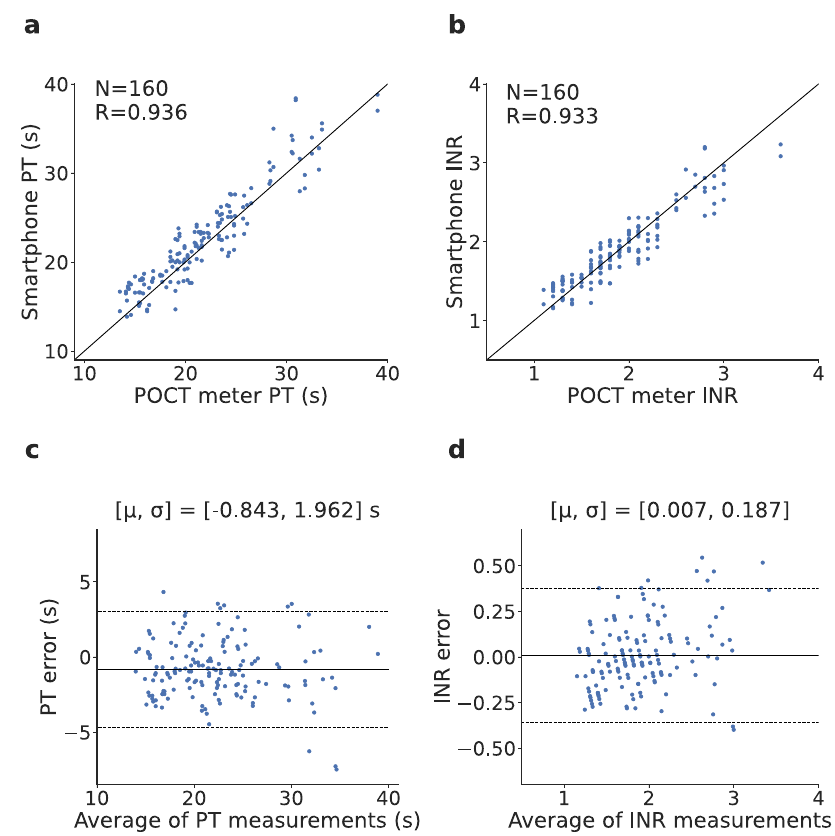
Fig. 5 Whole blood clinical testing results. a – d Correlation and Bland-Altman plots comparing whole blood PT/INR values from the smartphone system and the commercial POCT coagulometer. In the Bland-Altman plot, μ is the mean error and σ is the standard deviation (SD) of the errors, the solid line represents the mean error and the dotted lines represent the 95% limits of agreement. Source data are provided as a Source Data fi le.